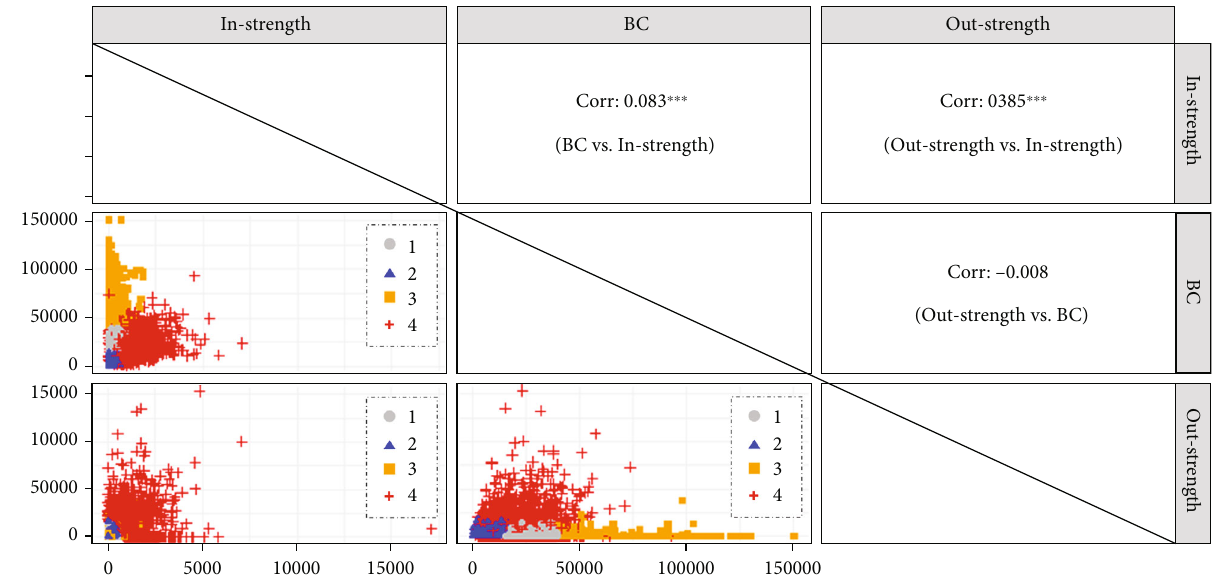
Figure 6: Clustered links and correlation among the three attributes.